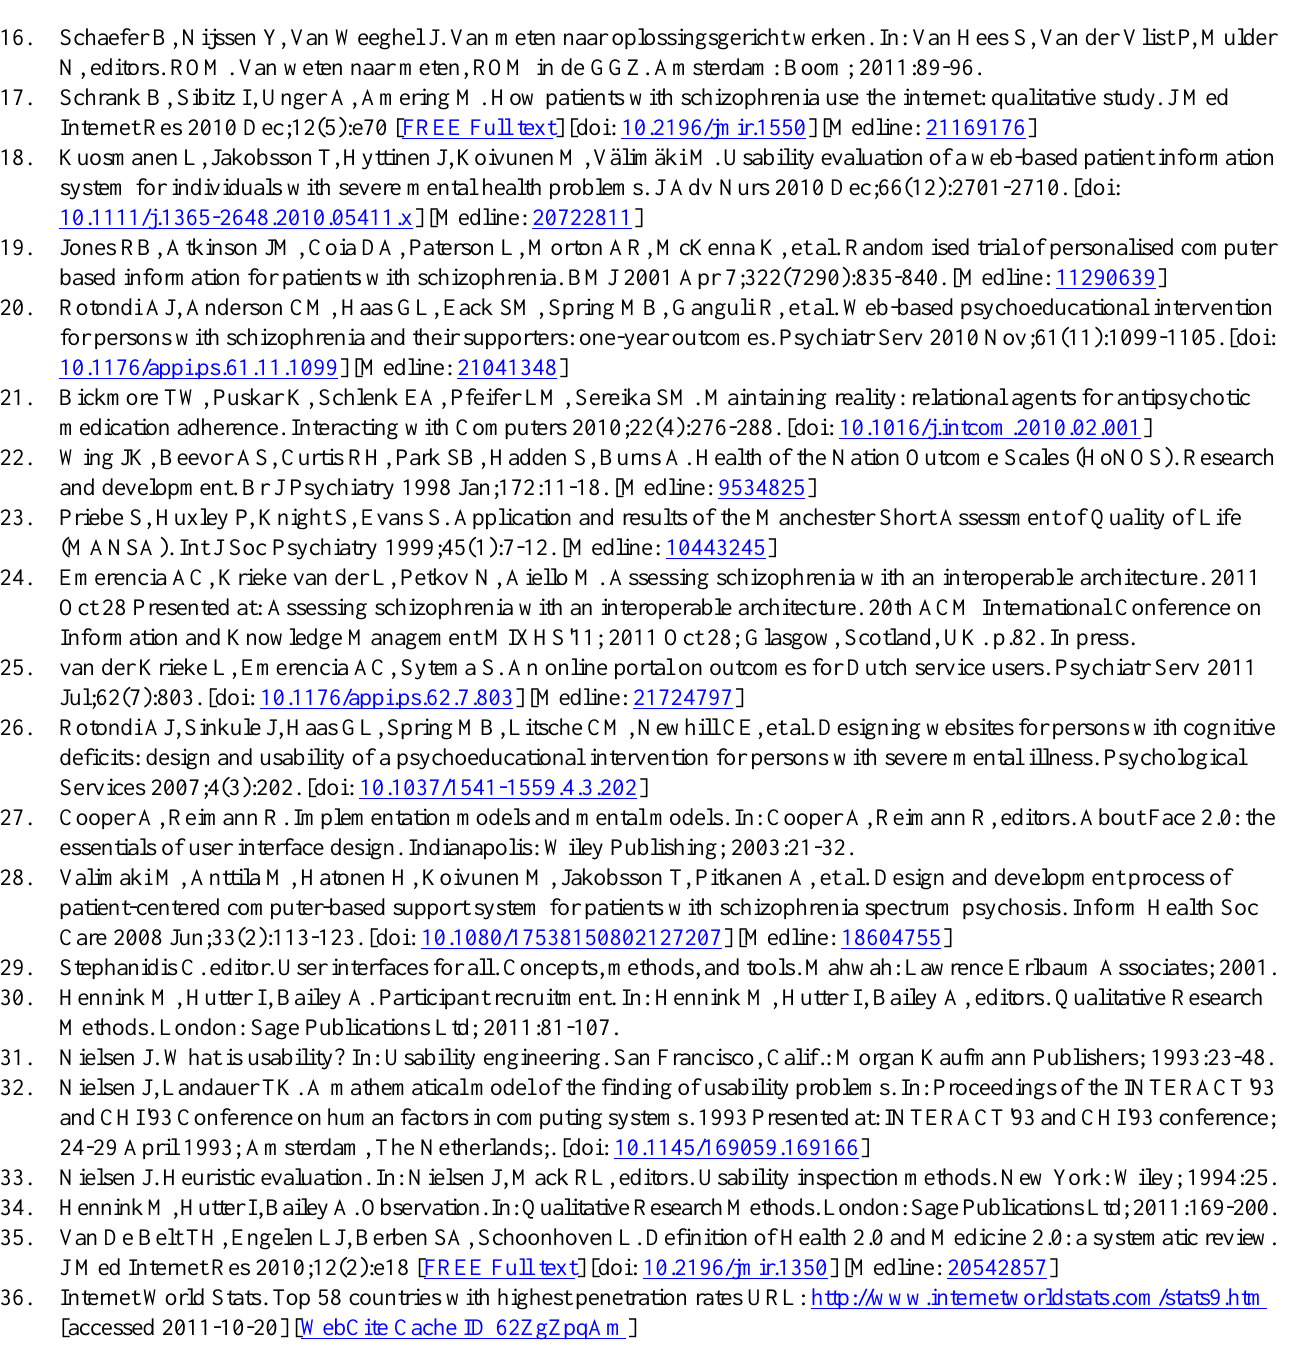
Abbreviations ICT: Information and Communication Technology ROM: Routine Outcome Monitoring WEGWEIS: name of the web-based support system described in this study. WEGWEIS is a Dutch abbreviation that stands for web environment for empowerment and individual